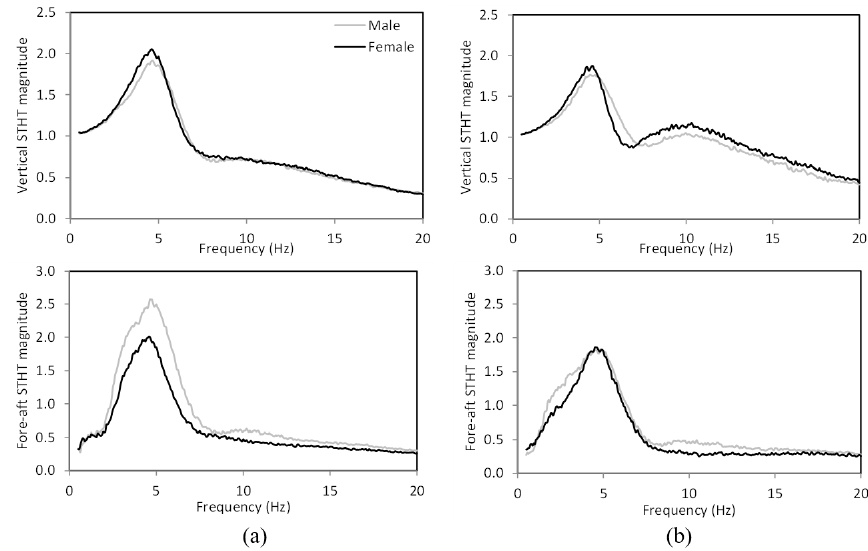
Figure 4. Mean vertical and fore-aft STHT magnitude responses of 31 males and 27 females: ( a ) without back support; and ( b ) with back support (excitation: 0.50 m/s 2 ).